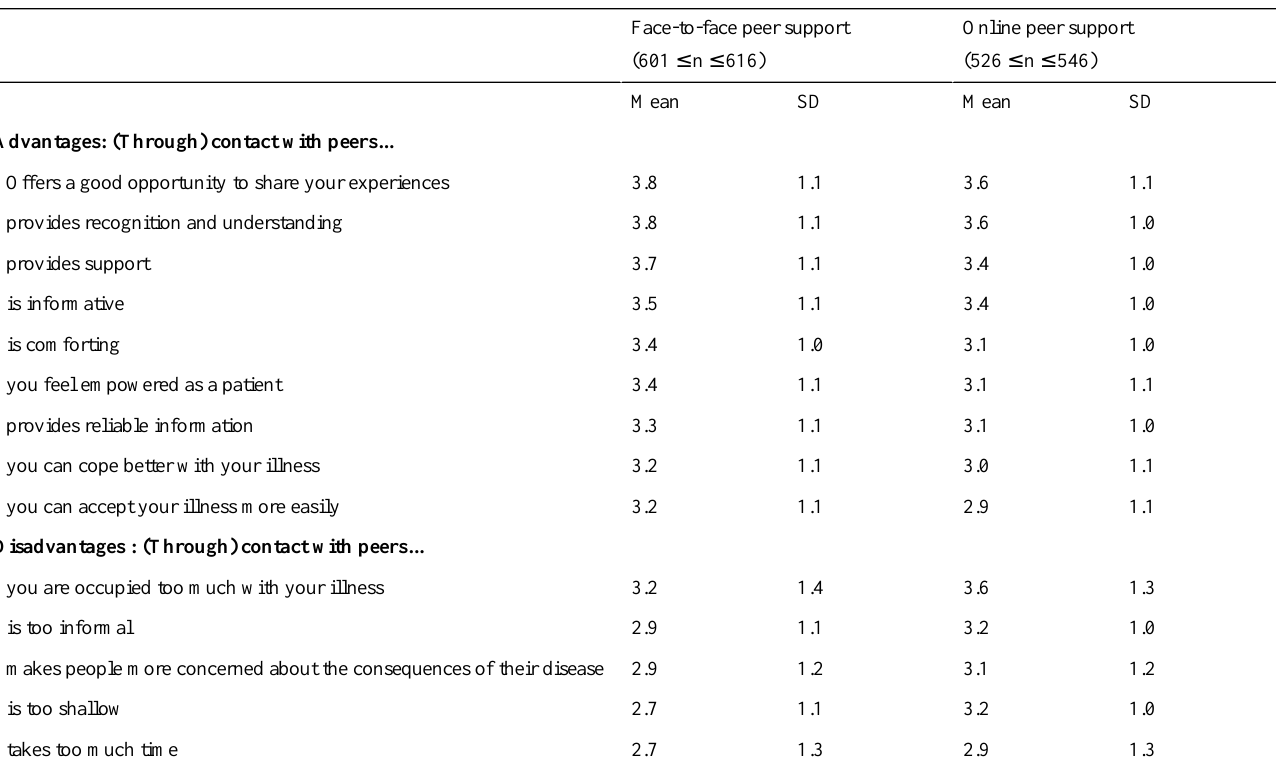
Table 4. Mean item scores (range 1–5) on attitude toward peer support